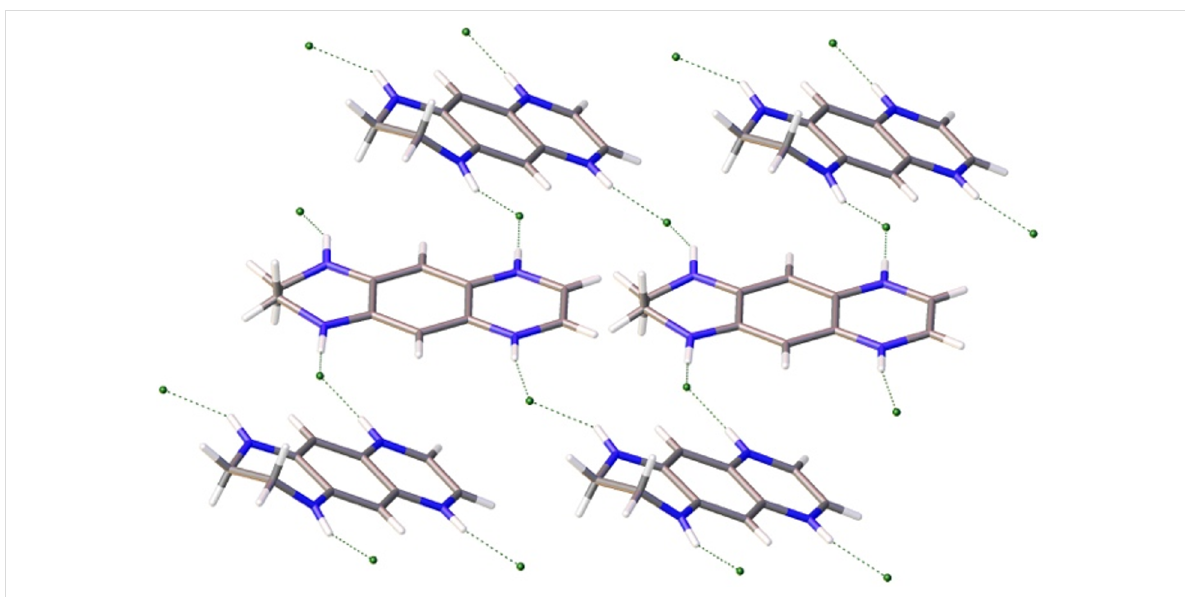
Figure 10: View of the supramolecular array generated by 6a in the solid state. Color coding: nitrogen, blue; carbon, grey, chloride, green.